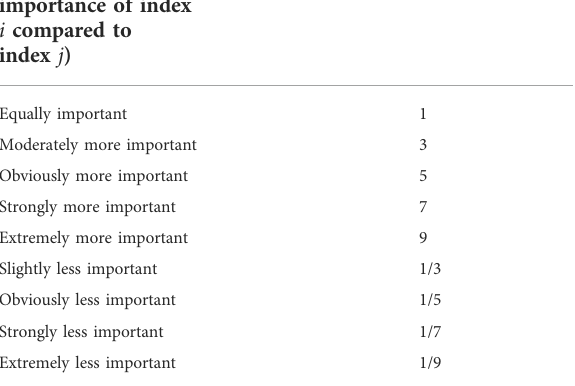
TABLE 2 The relative importance of evaluation